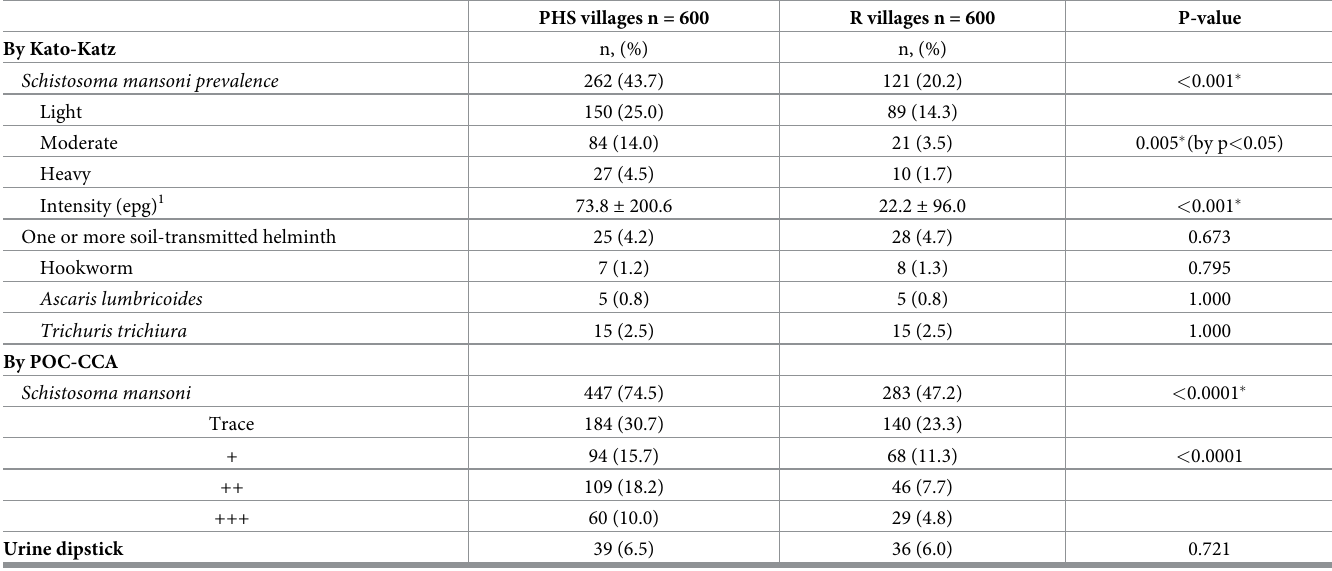
Table 2. Prevalence of Schistosoma mansoni and soil-transmitted helminths in PHS and R villages in western Kenya. PHS villages n = 600